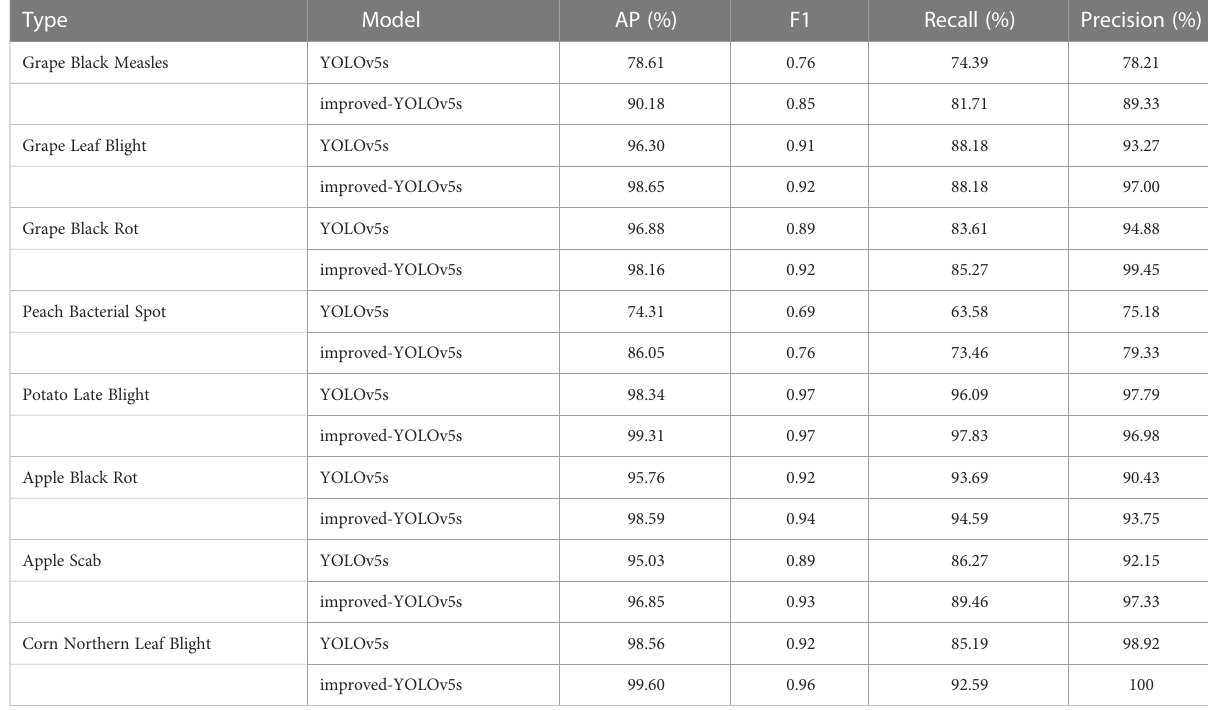
TABLE 3 Comparative results of 8 disease types.